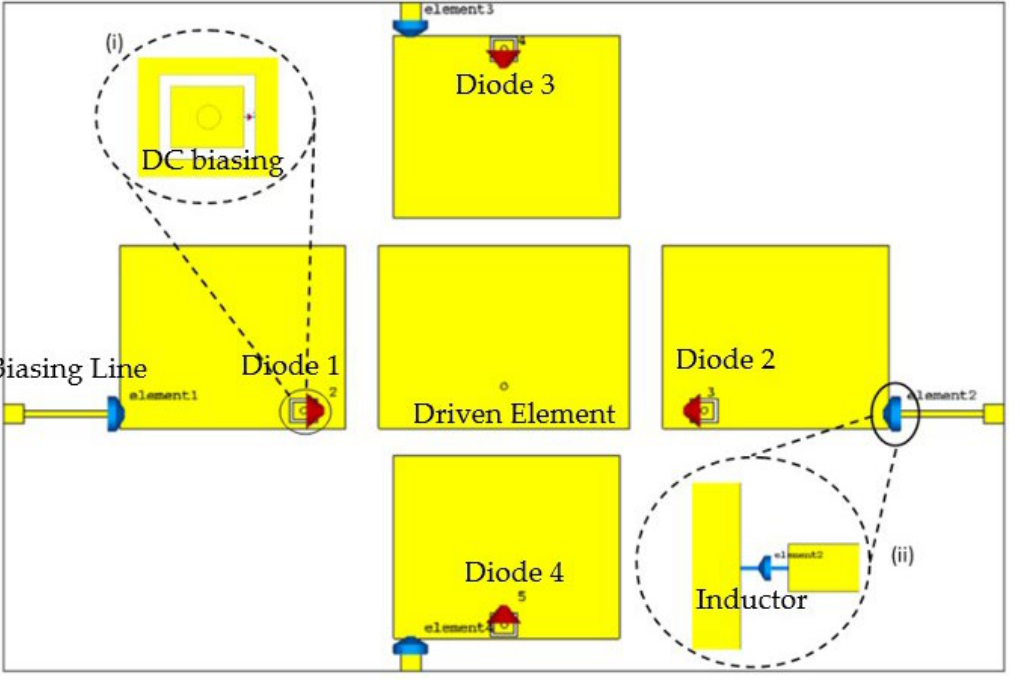
Figure 4. Front view of the optimized design of four-element parasitic with integration of biasing network for RF switches.